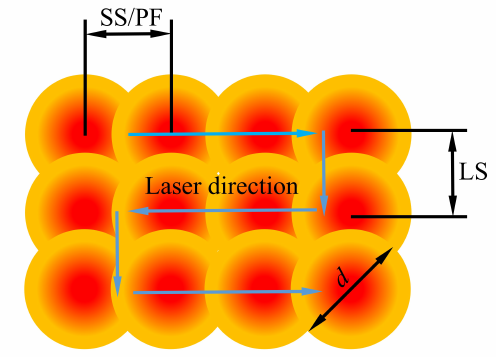
Figure 3. The laser pulse accumulation diagram of plane